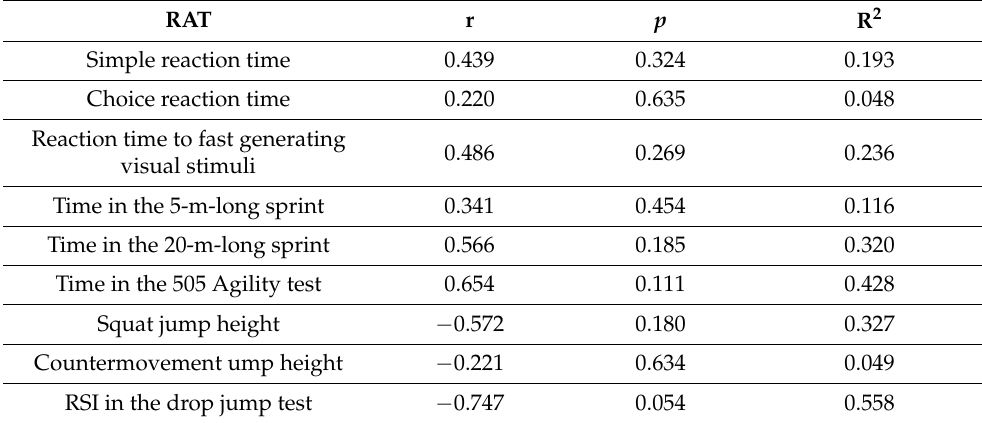
Table 4. Relationship between RAT performance and the reaction speed, sprint speed, and strength parameters.